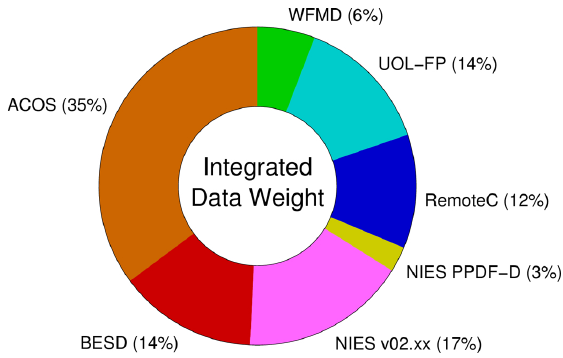
Fig. 3. Integrated data weight of each algorithm within the EMMA database defined as P 1 /σ 2 , where σ i is the (scaled) individual i sounding